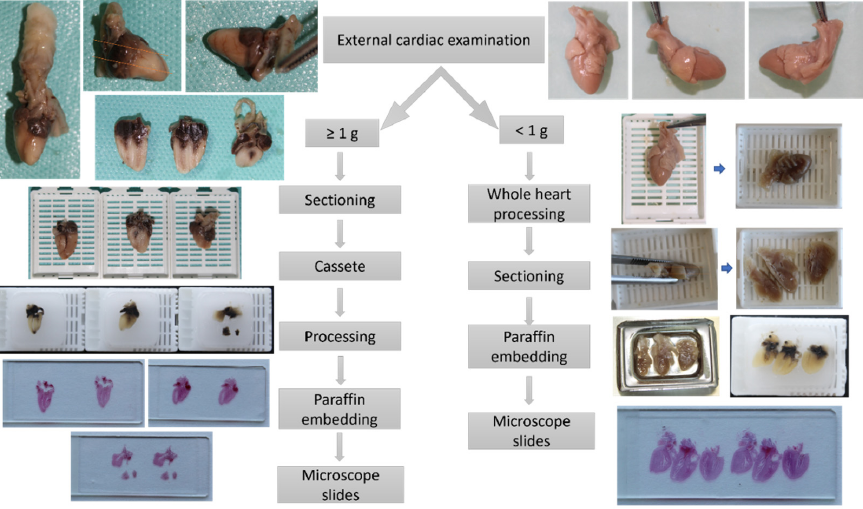
Figure 4. Workflow of proposed pathologic four-chamber examination method depending on the fetal heart weight. fetal heart